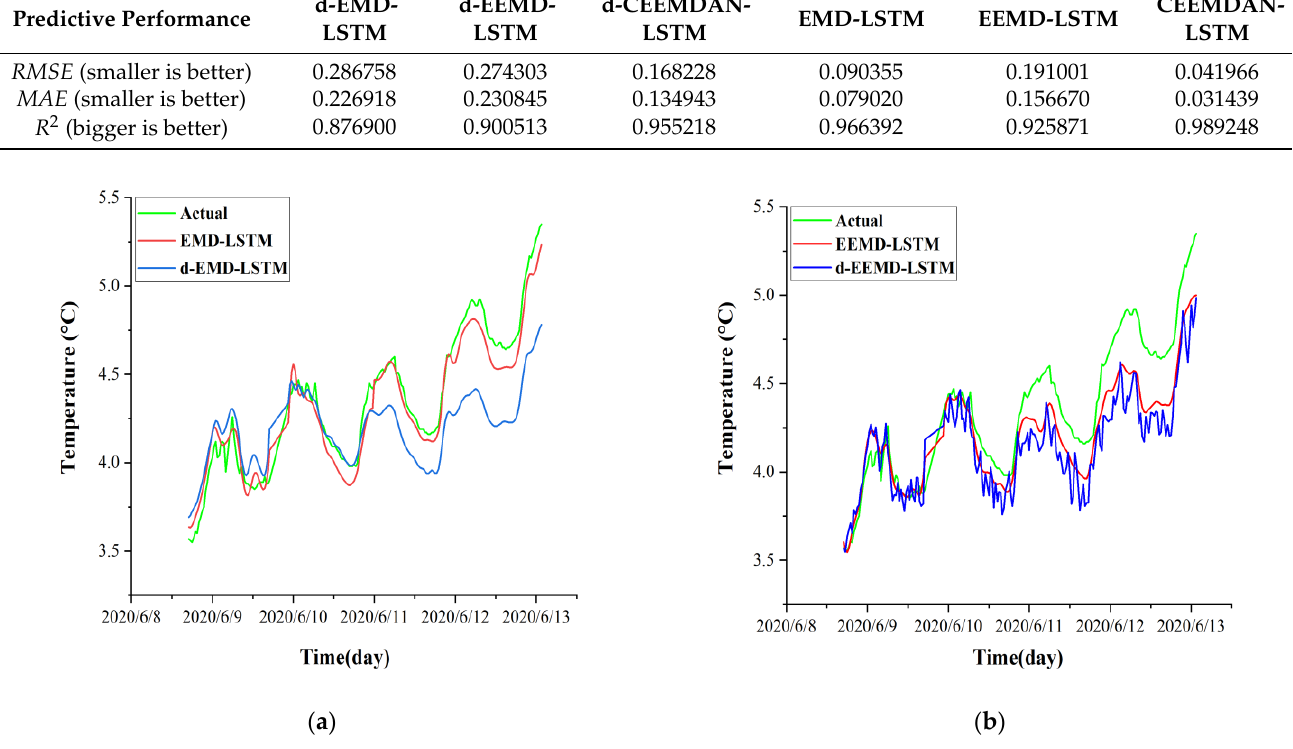
( d ) Figure 10. Comparison of prediction results of models with single dataset and hybrid dataset. ( a ) EMD-LSTM model (input hybrid dataset) versus d-EMD-LSTM model (input single dataset); ( b ) EEMD-LSTM model (input hybrid dataset) versus d-EMD-LSTM model (input single dataset); ( c ) CEEMDAN-LSTM model (input hybrid dataset) versus d-EMD-LSTM model (input single da- taset); ( d ) Comparison of prediction results of all models. 4.3. Comparison of Different Depth Prediction Models The data previously used in Sections 4.1 and 4.2 is at a subgrade depth of 0.5 m. In order to verify the predictive performance of the CEEMDAN-LSTM model at different subgrade depths, and then to determine whether it can be applied to different depths of the subgrade, the monitored temperature time series at different depths were decom- posed into EMD, EEMD, and CEEMDAN, then reconstructed into a hybrid dataset with the volumetric water content time series (H) and frost heave time series (D) at their cor- responding depths, then put into the LSTM model for training and finally for prediction. Due to paper space limitations, only the figures of CEEMDAN decomposition are shown in Figure 11.